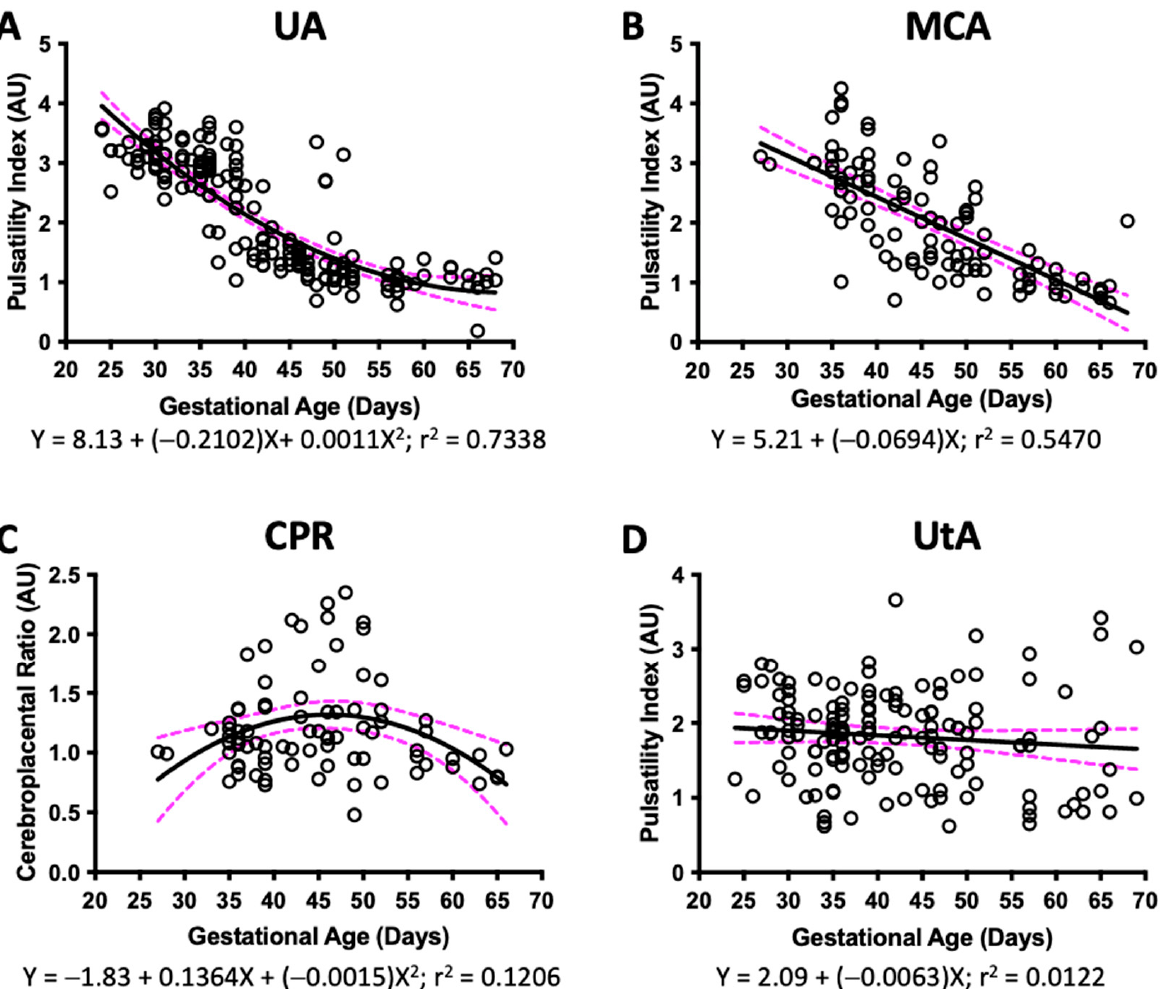
Figure 3. Doppler ultrasound across pregnancy. Guinea pig pulsatility index of ( A ) umbilical artery (UA), ( B ) middle cerebral artery (MCA), ( C ) cerebroplacental ratio (CPR), and ( D ) uterine artery (UtA) pulsatility index, and their best fit from gestational day 25 to the end of pregnancy. Each dot represents an individual measurement (n = 47 from 19 litters). Black line = data best fit. Magenta dashed lines = 95%CI.